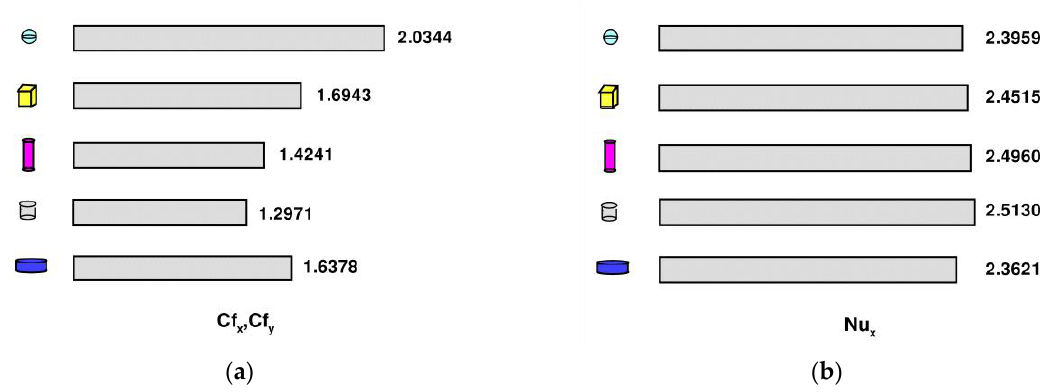
Figure 7. Skin friction coefficients Cf x , Cf y and local Nusselt number Nu x for various nanoparticle shapes when w 1 = w 2 = 10 gr, w f = 100 gr, σ = 0, and Pr = 6.2: ( a ) the distributions of Cf x , Cf y ; ( b ) the distributions of Nu x .